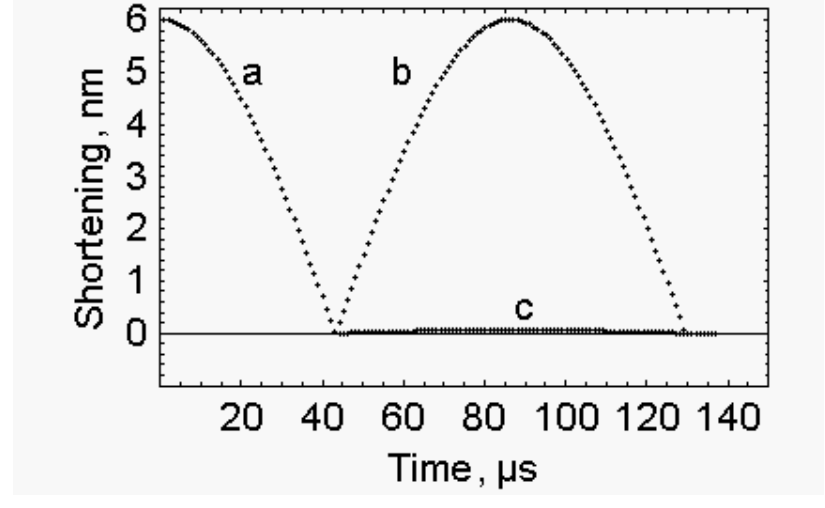
Figure 4. Quick release and subsequent lengthening due to the reflection against a hard boundary – a. Quick release, the conditions are the same as for Figure 1, calculations are made as described in Appendix A. b. Rapid recovery, the conditions are the same as for Figure 1, initial kinetic energy, 0.0815917 µJ; fibre stiffness, 0.015927 N/m; fibre mass, 1.2×10 -7 Kg; calculations are made as described in Appendix B. c. “Isometric” rapid recovery, initial kinetic energy, 0.0815917 µJ, fibre stiffness, 1.2713×10 6 N/m; fibre mass, 9.608×10 -4 Kg; calculations are performed as described in Appendix